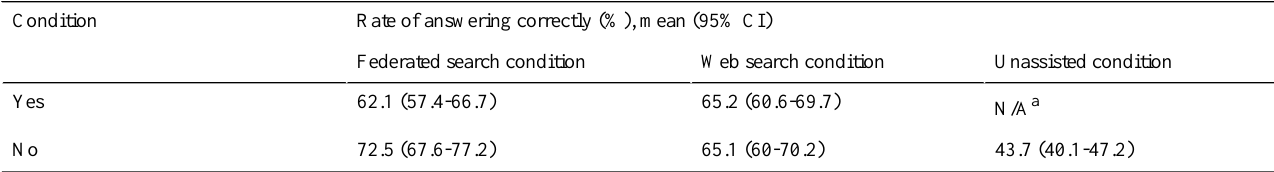
Table 3. Mean rate of answering correctly (with 95% CI) for each condition in the absence or presence of an information need. Rate of answering correctly (%), mean (95% CI)Condition